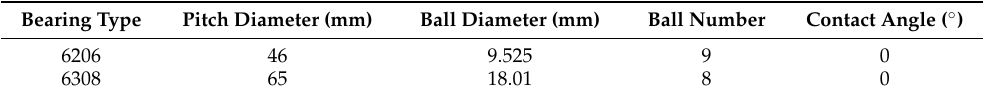
Table 3. Structural parameters of tested